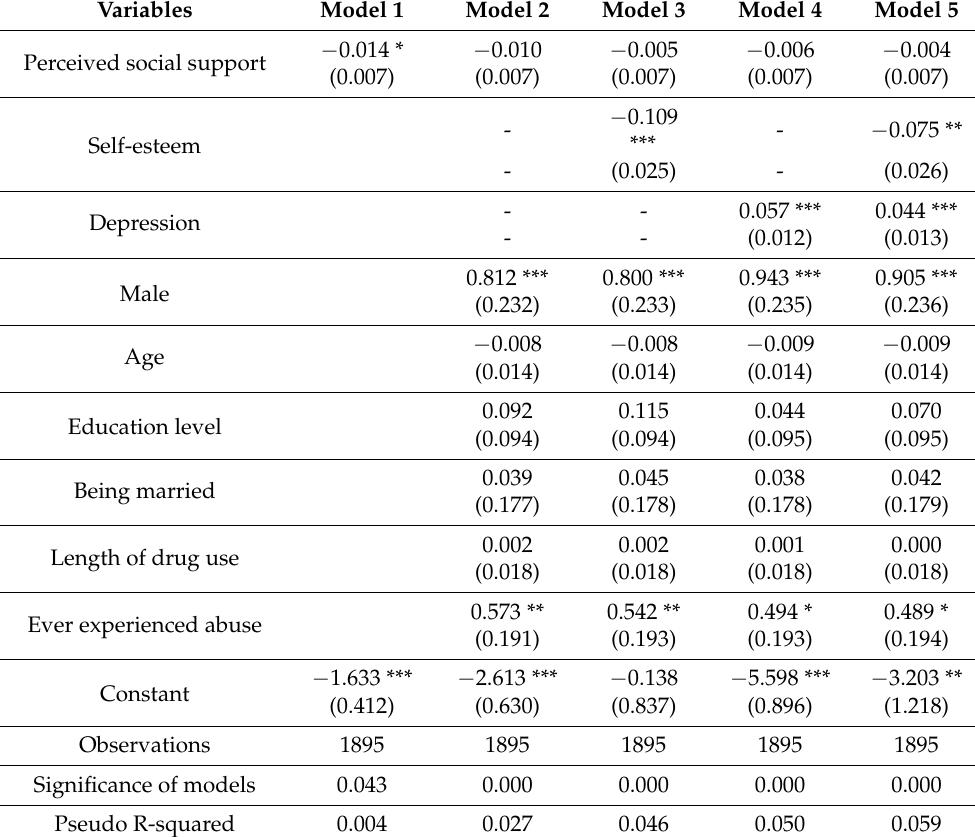
Table 3. Logistic regression models for suicide